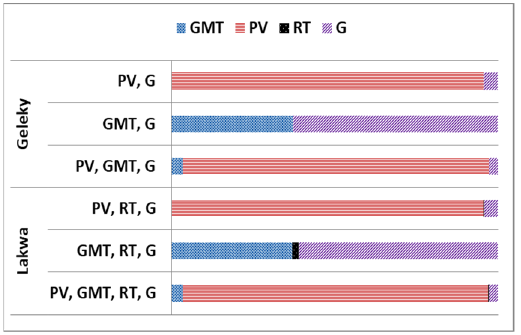
Figure 8. Share of electrical power consumption by each component of the selected HES.